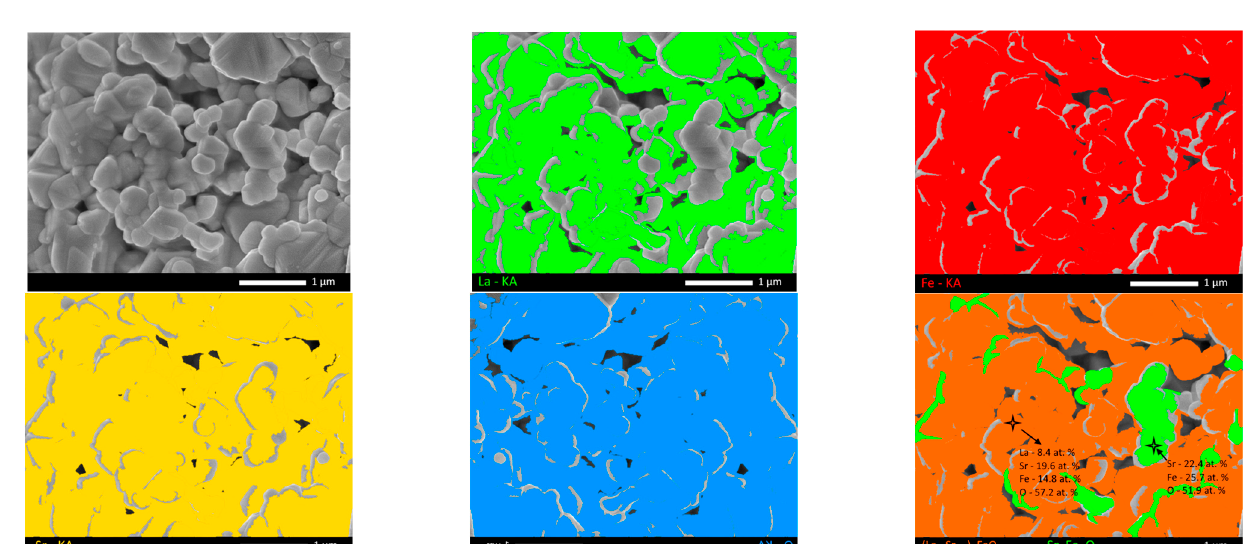
Figure 4. Mapping results of the studied powders with La concentration equal to 0.25 mol.